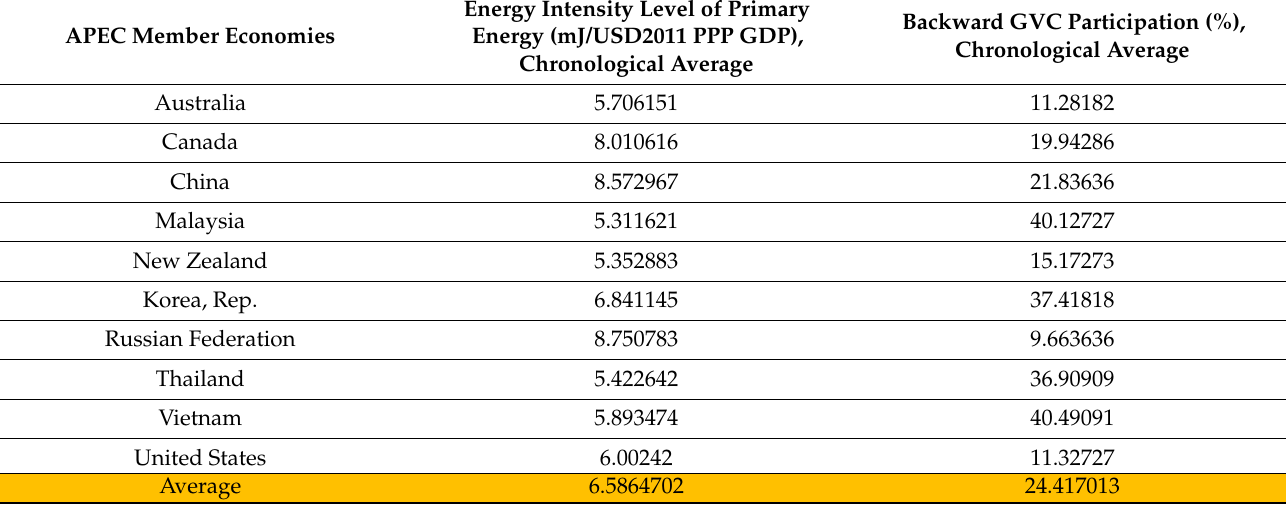
Table 16. APEC member economies with higher energy intensity level of primary energy.